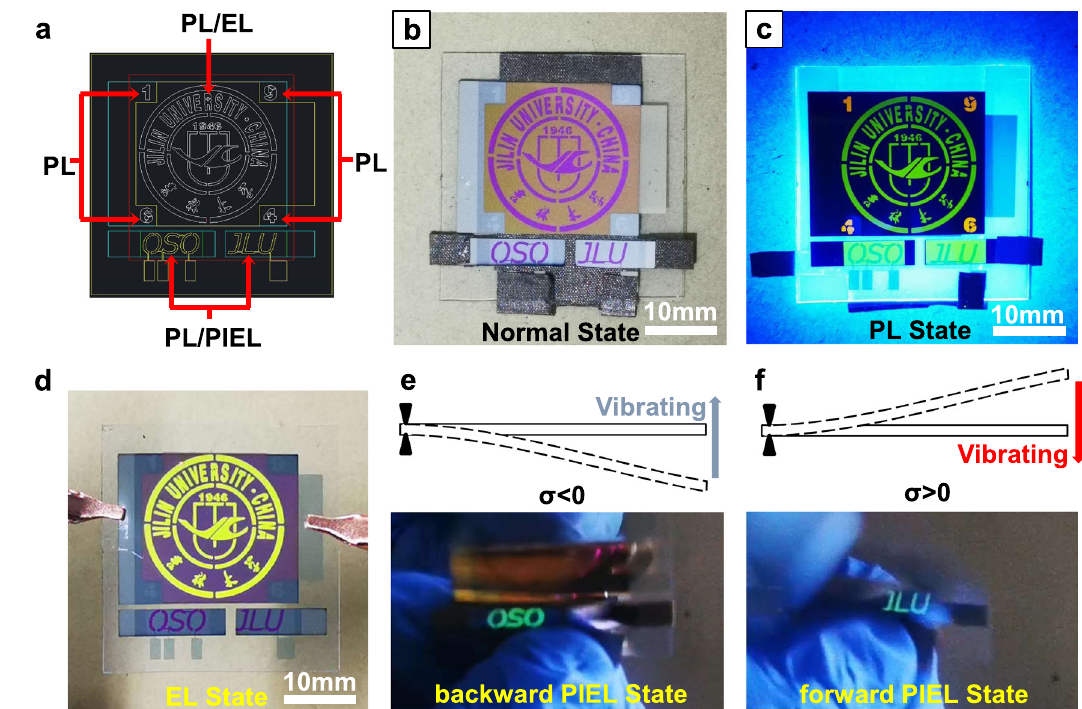
Fig. 5 | Different operation modes of the multi-functional anti-counterfeiting device. a Schematic diagram of the functional sections and structure of the demo pattern. Patterns of each color refer to different masks in OLED evaporation pro- cess. Optical images of different anti-counterfeiting modes are shown respectively